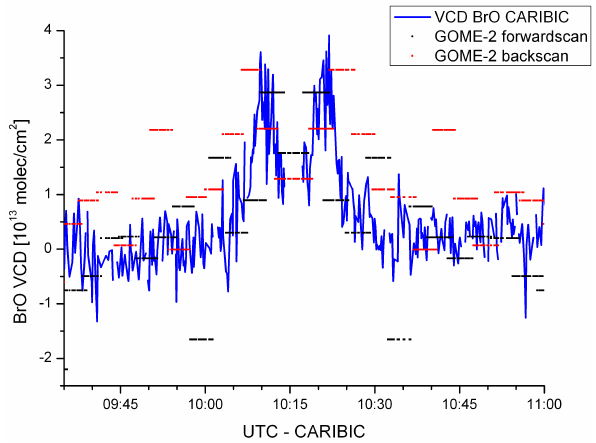
Fig. 15. Comparison of the BrO vertical column densities. Again the structure of the BrO peaks is well discernible in the GOME-2 data and also the vertical column densities are very similar.